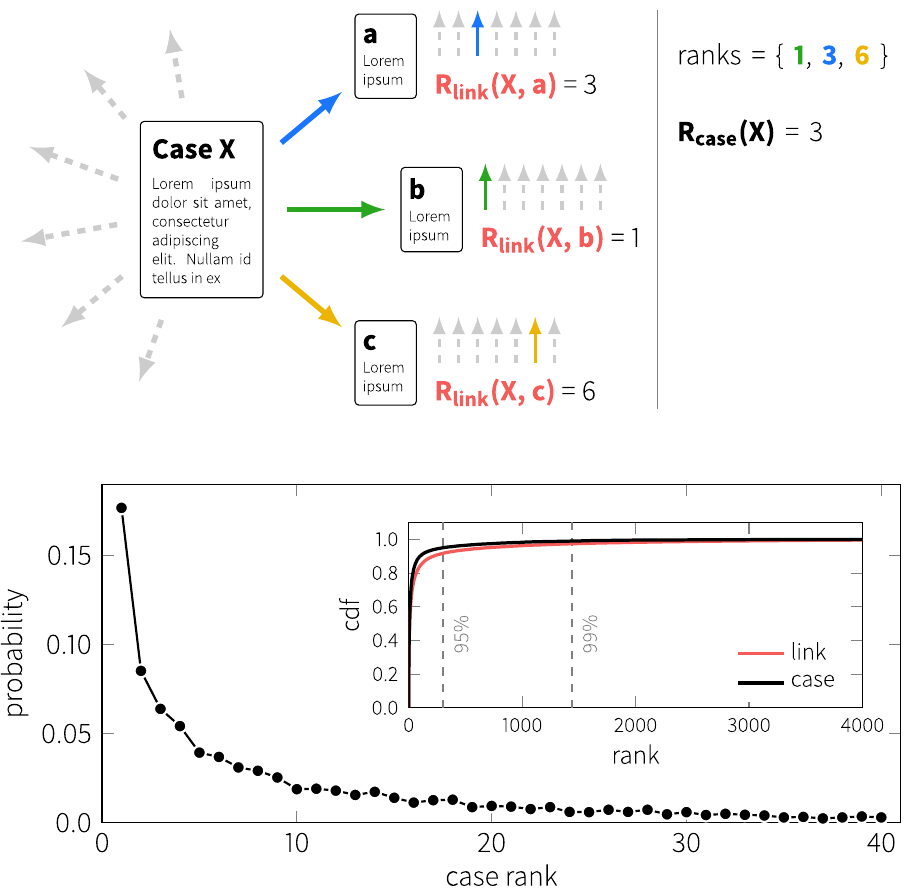
Figure 2. Global performance of the link prediction. Top: definition of the median prediction rank performance measure: each link of a case (colored arrows) is compared against all non-existent links (dashed gray) providing the link ranks (bold red). The full median prediction rank (calculated for each case)is defined as the median rank of outward links corresponding to the case (bold black). Main plot shows the probability mass function of low case ranks, inset shows the cumulative distribution function of the link (red) and case ranks (black). Dashed lines mark the 95% and 99% percentage of the total number of